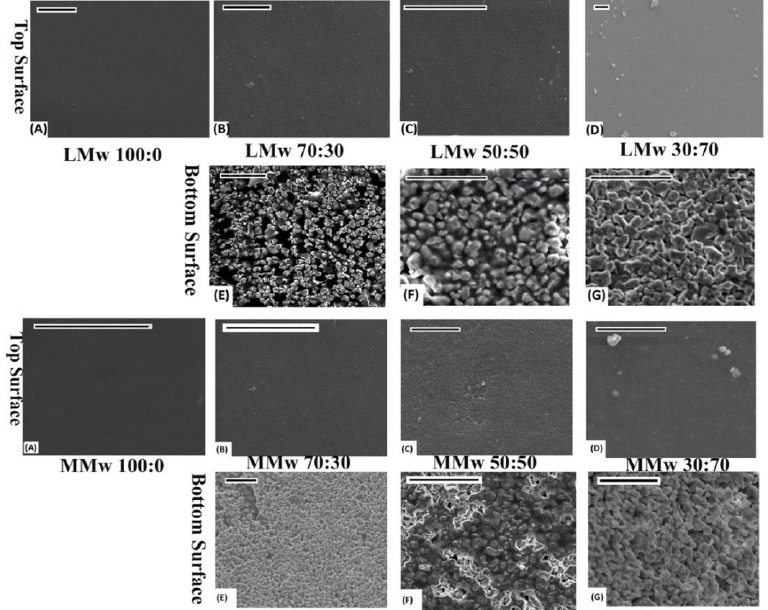
Figure 2. SEM performed on LMW and MMwCH:HA membranes. Top and bottom surface of 100:0, 70:30, 50:50 and 30:70 ratios of CH:HA. All images scaled at 20 µm. ( a − d ) are top surfaces of LMw and MMw Neat and composite membranes. ( e − g ) are bottom surfaces of composite LMw and MMw membranes.